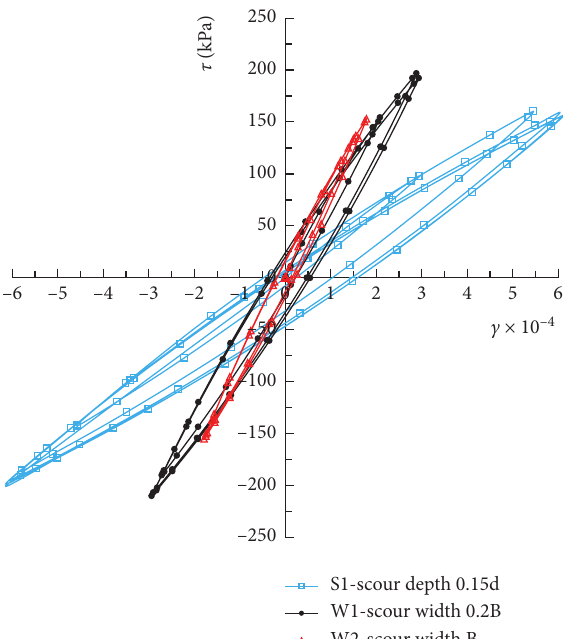
Figure 14: Stress-strain hysteresis loops of the surface soil under different scour depths.